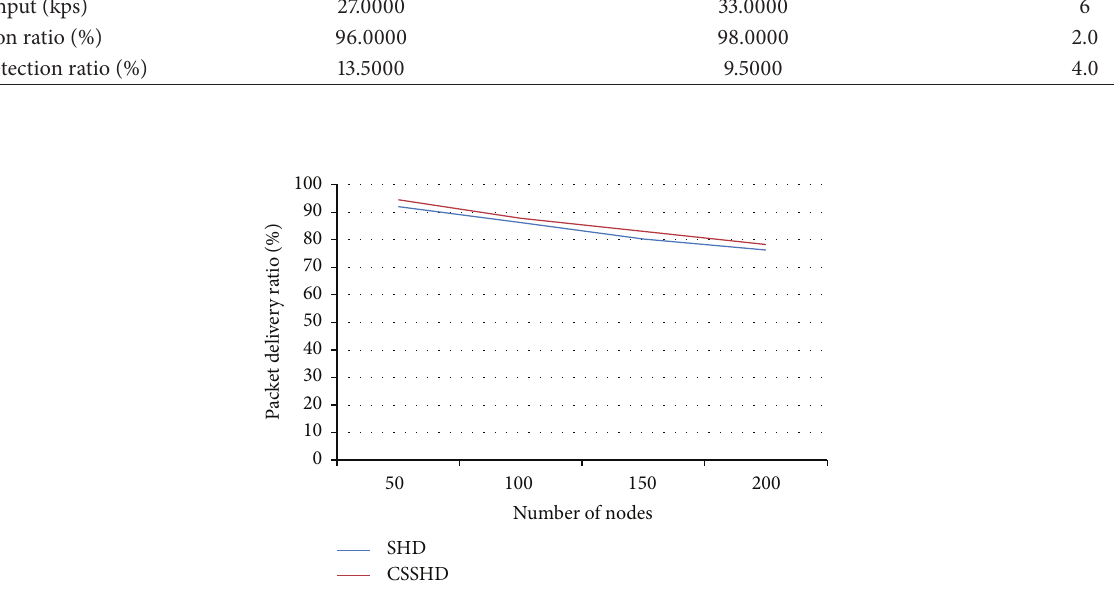
Figure 4: Graph for packet delivery ratio.